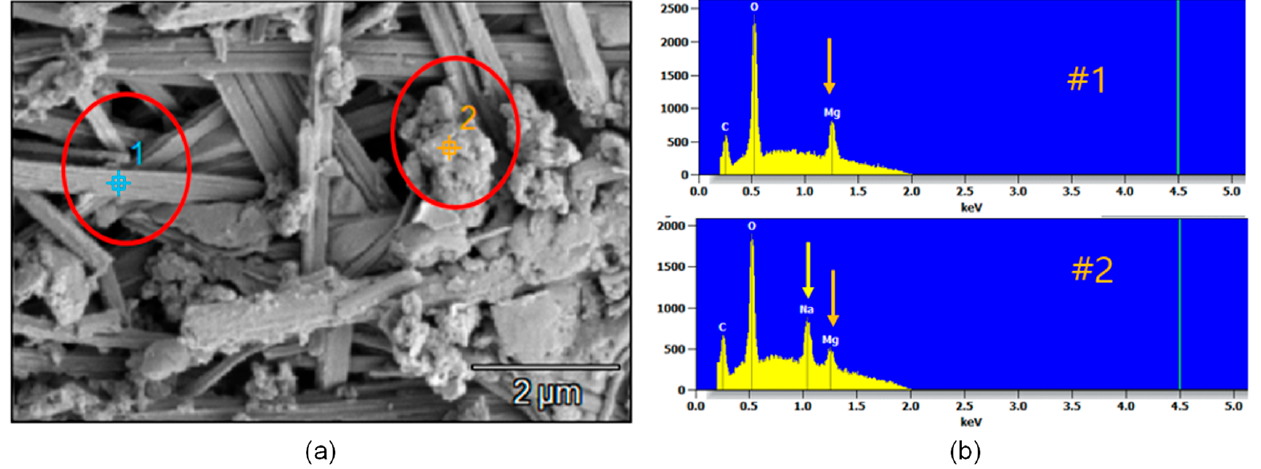
Figure 13. SEM/EDAX image of the cross-section of the concrete sample TP3-3 at the tip of a surface-breaking crack after EDT process: ( a ) SEM image, ( b ) distribution of primary elements in the regions 1 and 2 in the SEM image shown in Figure 13a.